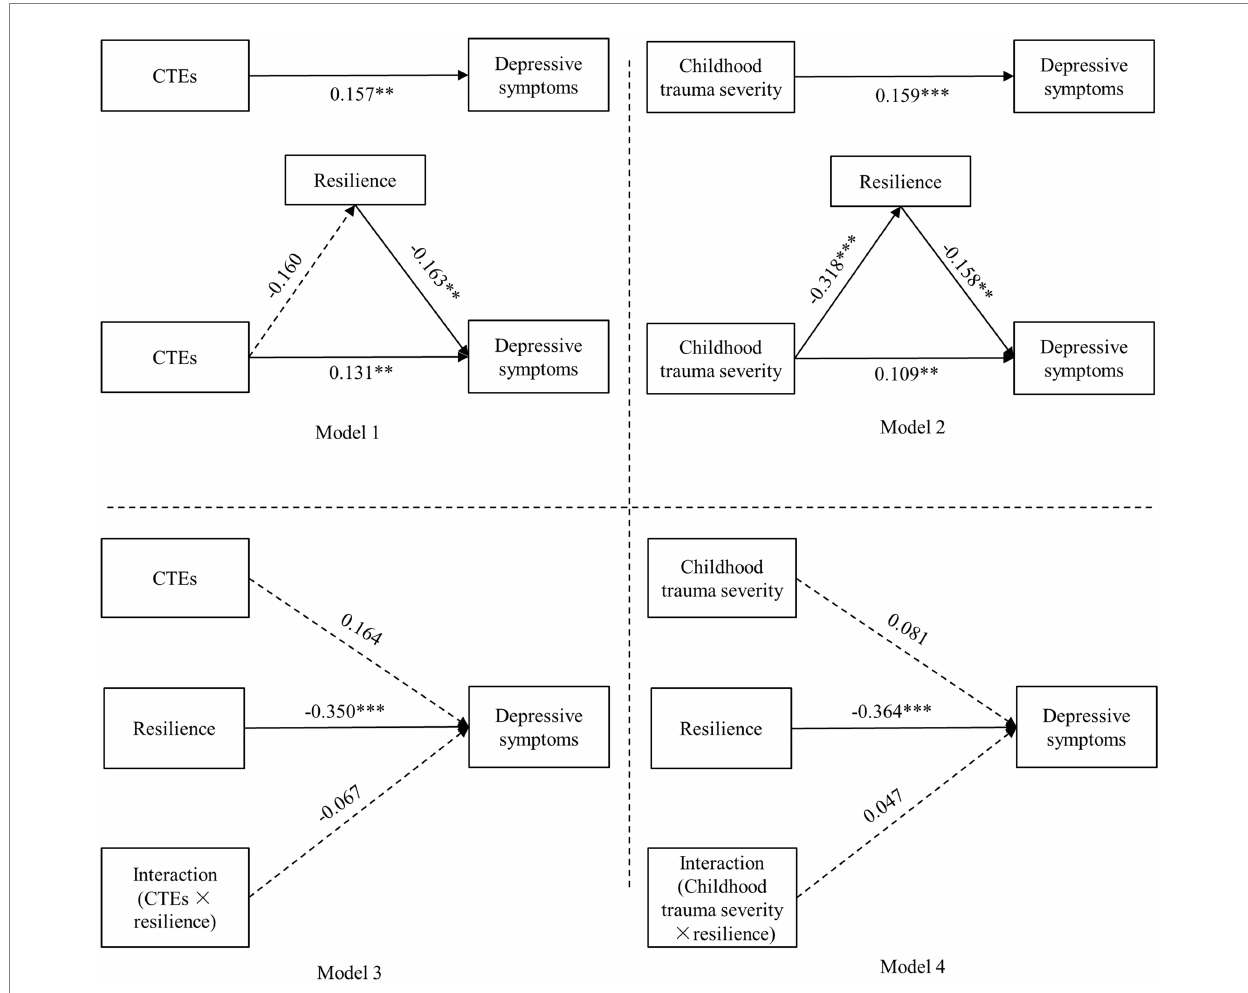
FIGURE 1 Test for the mediating and moderating effects of resilience in the association between childhood trauma and depressive symptoms. Model 1 and Model 3 were the mediation and moderation models of resilience in the associations of childhood traumatic events (CTEs) with depressive symptoms, respectively. Model 2 and Model 4 were the mediation and moderation models of resilience in the associations of childhood trauma severity with depressive symptoms, respectively. * p < 0.05, ** p < 0.01, *** p < 0.001; all coefficients are unstandardized coefficients; the solid line represents the path that is statistically significant ( p < 0.05), and the dashed line represents the path that is not statistically significant ( p >